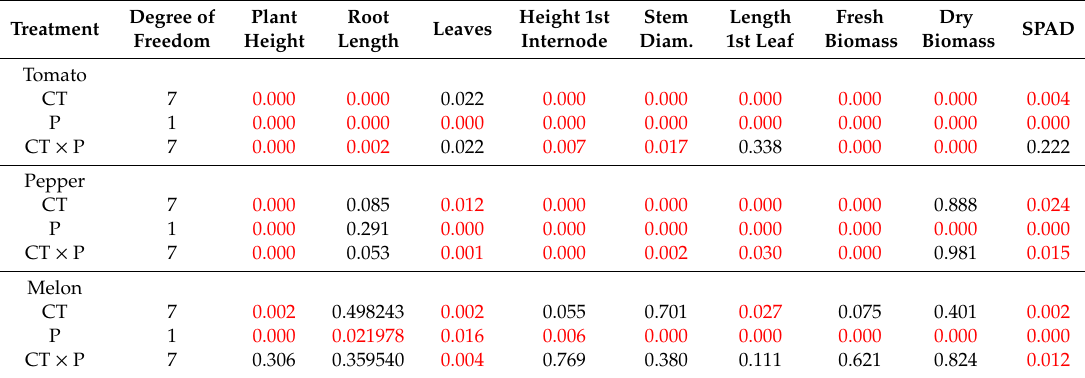
Table 3. Significance probability levels, red colored if they are ≤ 0.05, resulting from Analyses of Variance for the selected morphological characteristics of tomato, pepper and melon seedlings as affected by compost tea (CT) and Previcur (P).